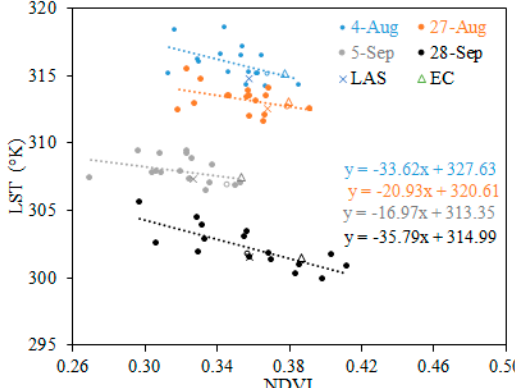
Figure 8. Plot of LST–NDVI space, along with isolines for each Landsat overpass date.